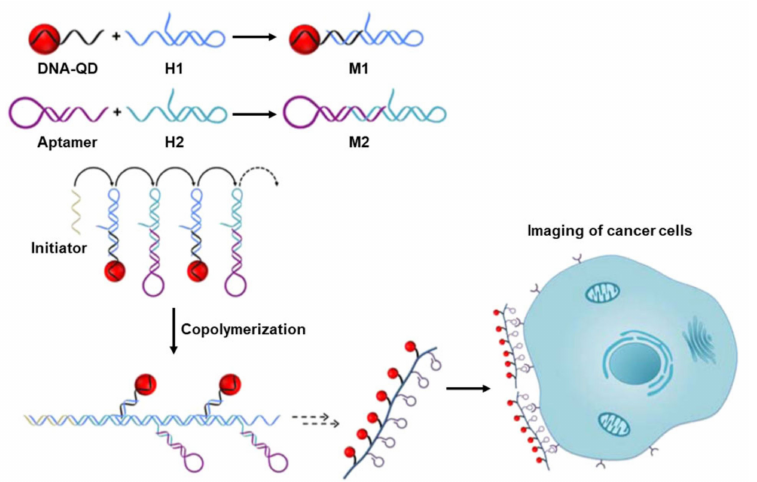
Figure 13. Construction of QD-aptamer polymers (QAPs) via an HCR-based strategy for cancer cell detec- tion. Adapted with permission from Anal. Chem . 2016, 88, 9355–9358, doi:10.1021/acs.analchem.6b02864. Copyright (2016) American Chemical Society